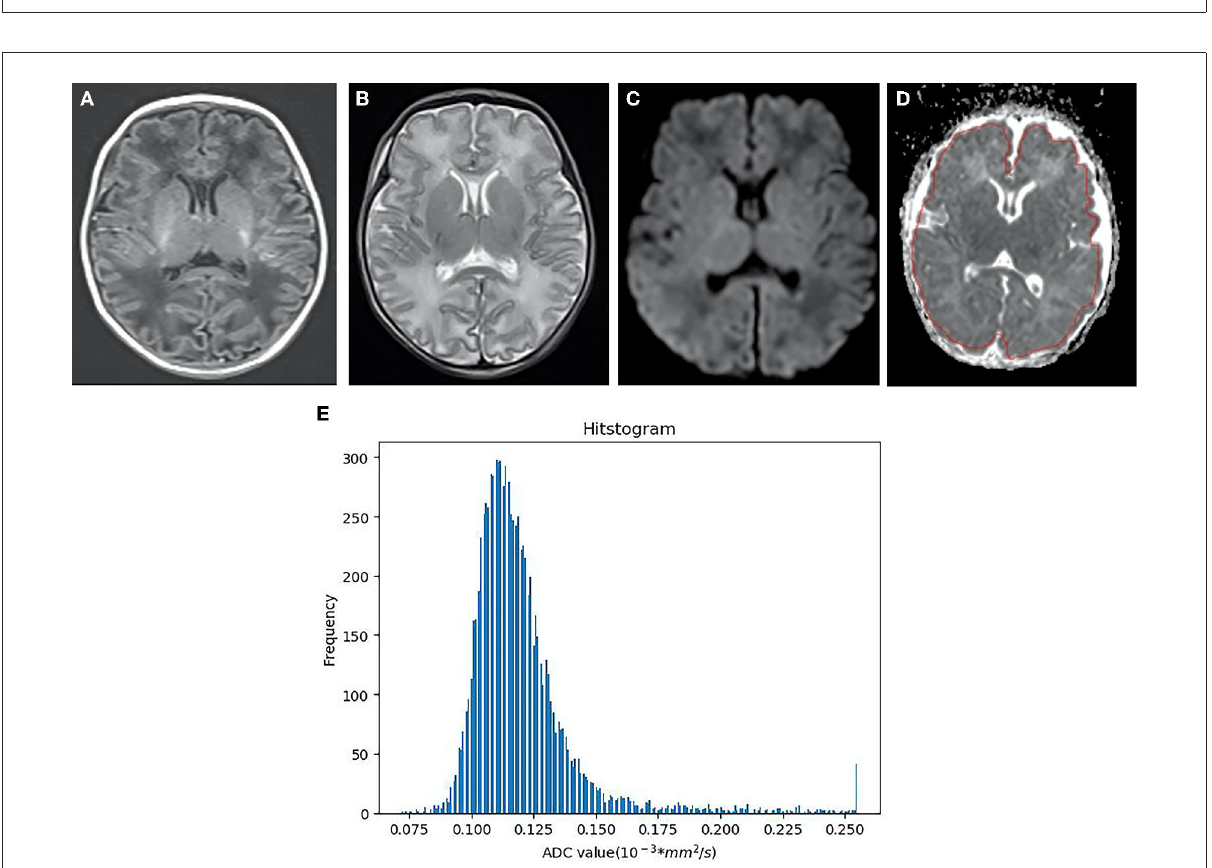
FIGURE4 Neonatal with HIE in the mild group, female, 6 days old. (A) T1WI sequence, punctate and striped T1 high signal in bilateral frontal parietal cortex and subcortical cortex. (B) T2WI sequence, the white matter signal is slightly higher. (C) DWI, punctuate hyper signal close to the left lateral ventricle. (D) The identical area was selected as that in the moderate-to-severe group to draw ROI. (E) As indicated from the ADC histogram of the mild group, the distribution of the ADC values is more symmetrical than that of the moderate-to-severe group, the distribution width is narrower, and the highest frequency value is lower than that of the moderate-to-severe group ( X -axis represents ADC value, Y -axis denotes the pixel frequency corresponding to ADC